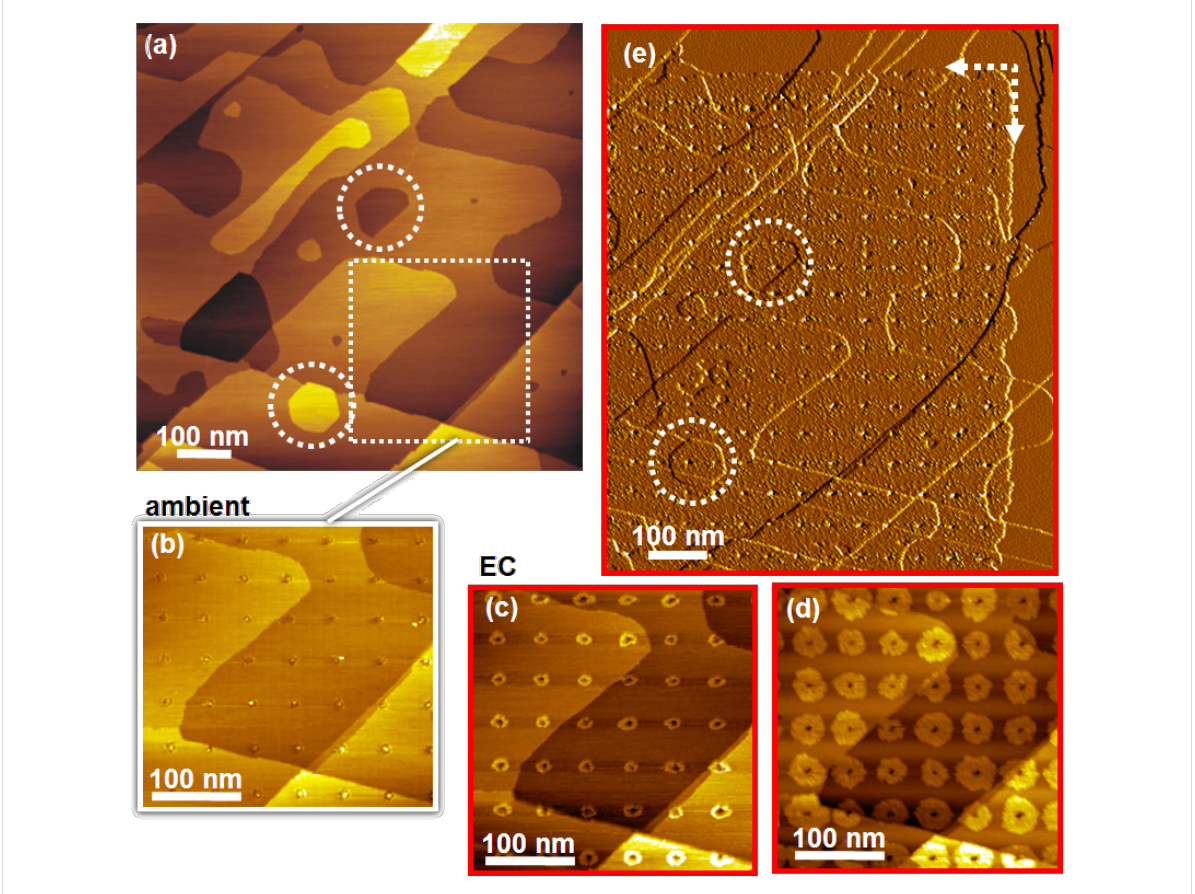
Figure 3: Temporal evolution of Cu-UPD. (a) Large scale ambient STM image of a native BP2 SAM on Au. (b) Magnified image of the area marked by the square in (a) after patterning with voltage pulses of 3.8 V for 50 ms. (c,d) EC-STM images of the area shown in (b) after different periods of UPD, 176 min (c) and 329 min (d) with the sample potential decreased from initially 0.4 V to 0.2 V vs Cu 2+ /Cu. (e) Large scale STM image after the UPD islands have coalesced to a uniform area. Circles in (a,e) mark identical areas. The dashed arrows in (e) mark boundary between UPD areas and passivated areas. (a–d) show constant current images, in (e) the derivative is shown for better visual differentiation between native and UPD modified